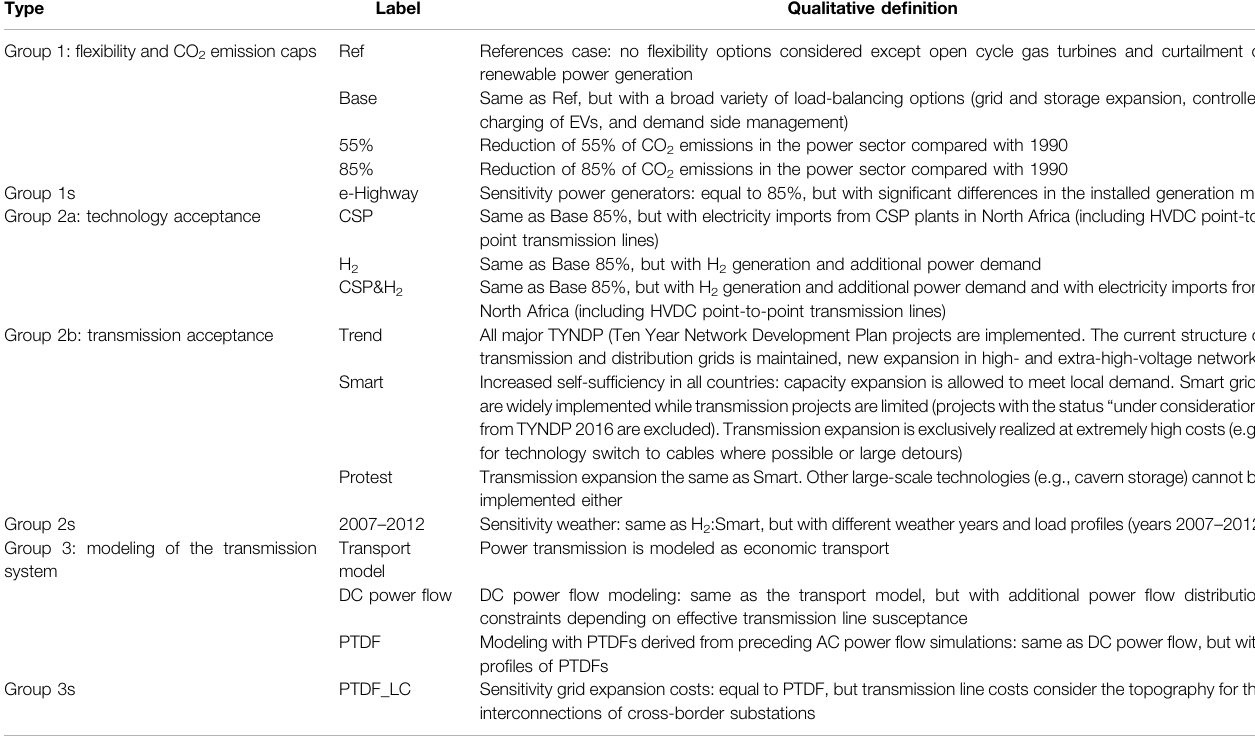
TABLE 1 | Qualitative speci fi cation of scenarios and model parameterization. Type Label Qualitative de fi